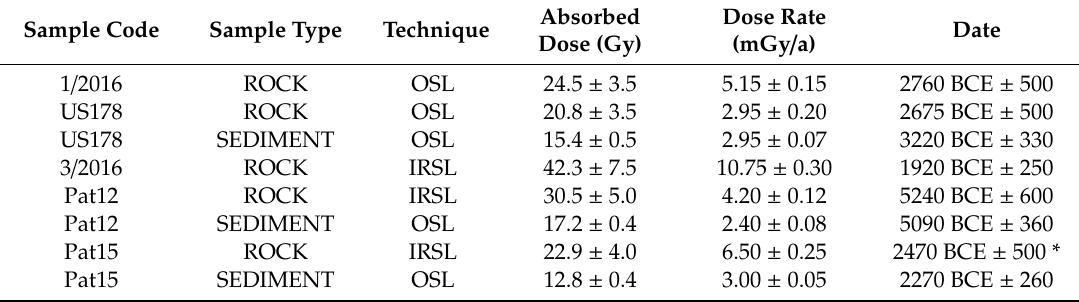
Table 3. Cobbles and sediments calculated ages.